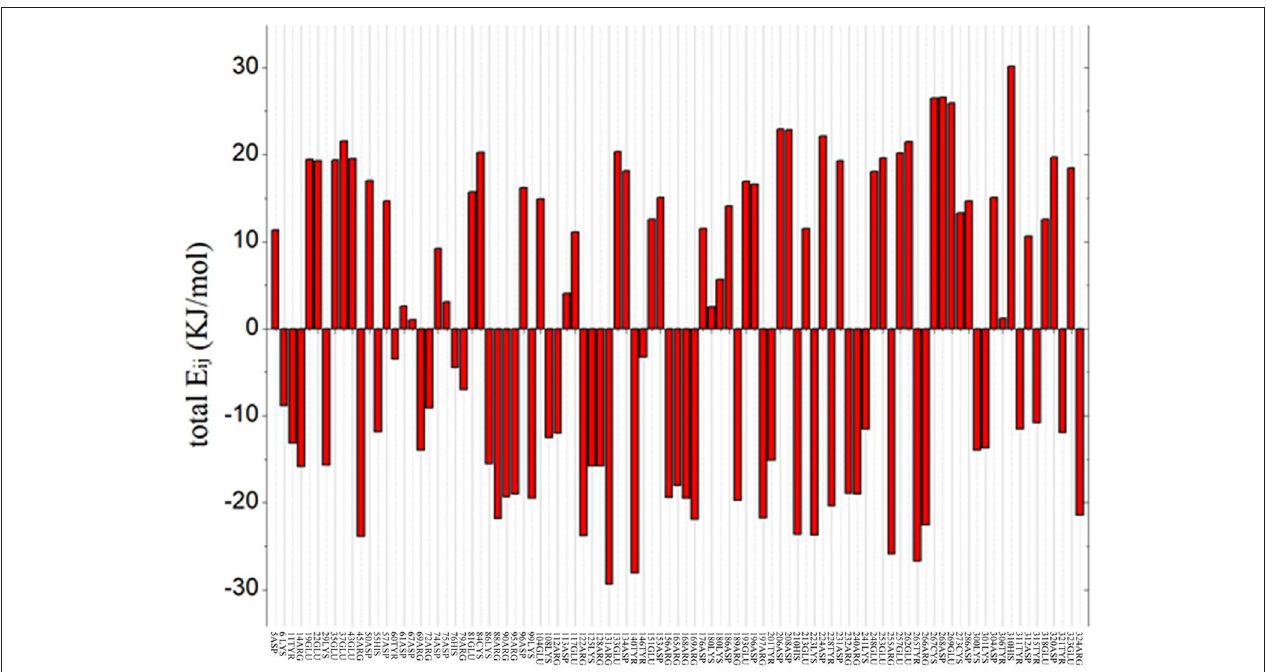
FIGURE 1 | Total energy of each chargeable residue. Positive value indicates the overall contribution of repulsive force to the thermal stability of protein structure, whereas negative value represents the overall contributions from gravitation, which is beneficial to the thermostability of the protein structure.